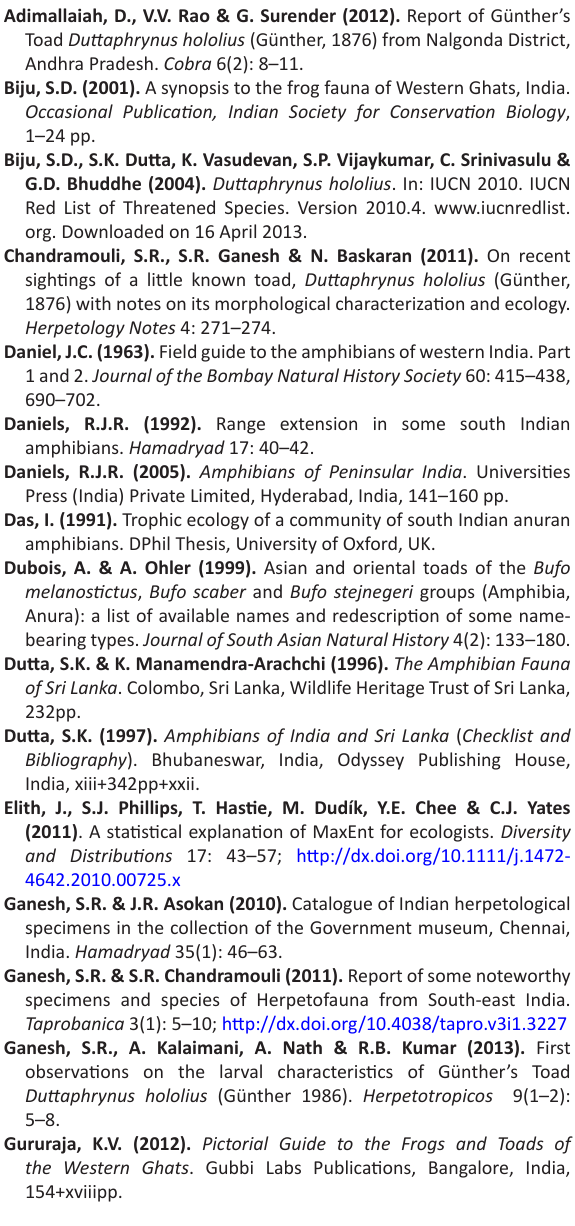
Image 5. Dwarf Toad Duttaphrynus scaber a live uncollected